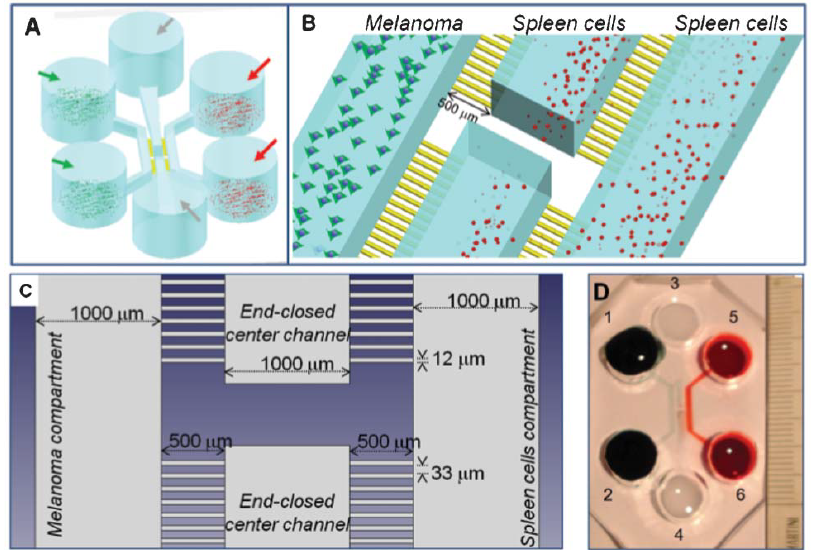
Figure 4. Microfluidic chip environment. Panel ( A ): schematics of the 3-D configuration of the whole chip. Panel ( B ): schematics of the central, active portion of the chip. Panel ( C ): 2D-representation of the active, central portion of the chip as modeled. Panel ( D ): actual photograph of the microfluidic device. Credit: Businaro et al. (2013) [1], edited by The Royal Society of